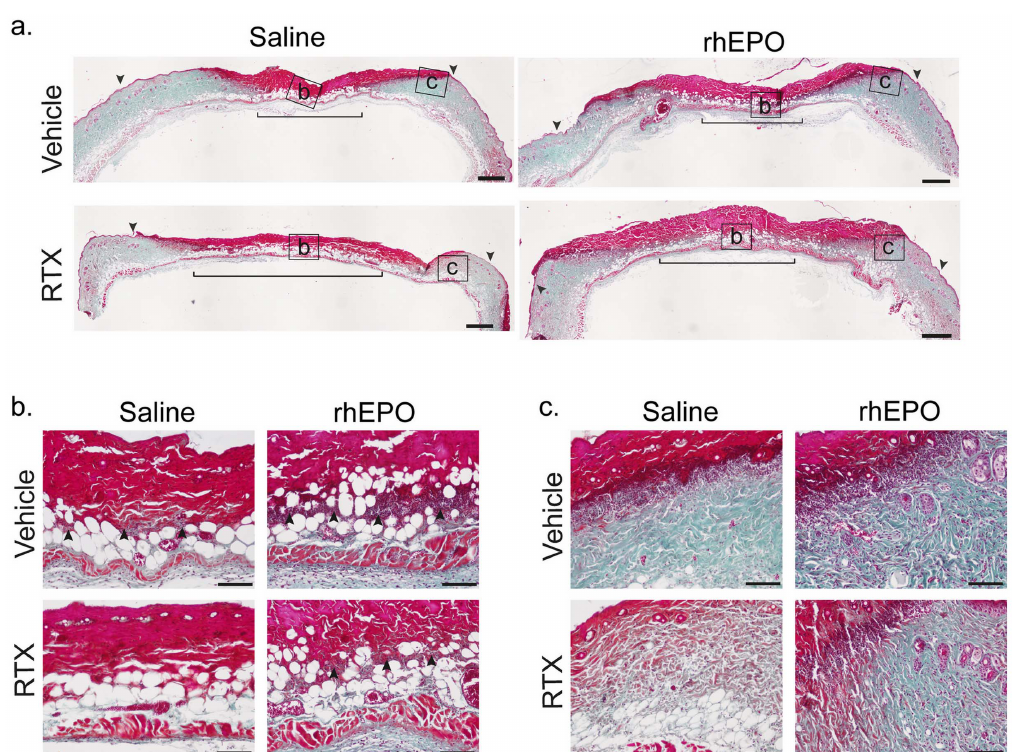
Figure6.EffectsofRTXandrhEPOoncutaneoushistologicalfindings24 hafterpressurerelease. Ischemic skin lesions were removed 24 h after pressure release and stained with Masson’s trichrome. ( a ) Histological look of pressure ulcer (PU). Bracket delimits area where necrosis is the most profound and arrows mark the margin of the lesion. Scale bar 5 500 m m. ( b, c ) Microphotographs taken from (a) of central compressed area (b) and of ischemic wound margins (c). Arrows indicate infiltrates of inflammatory cells. Scale bar 5 100 m m. rhEPO: recombinant human erythropoietin, RTX: resiniferatoxin.